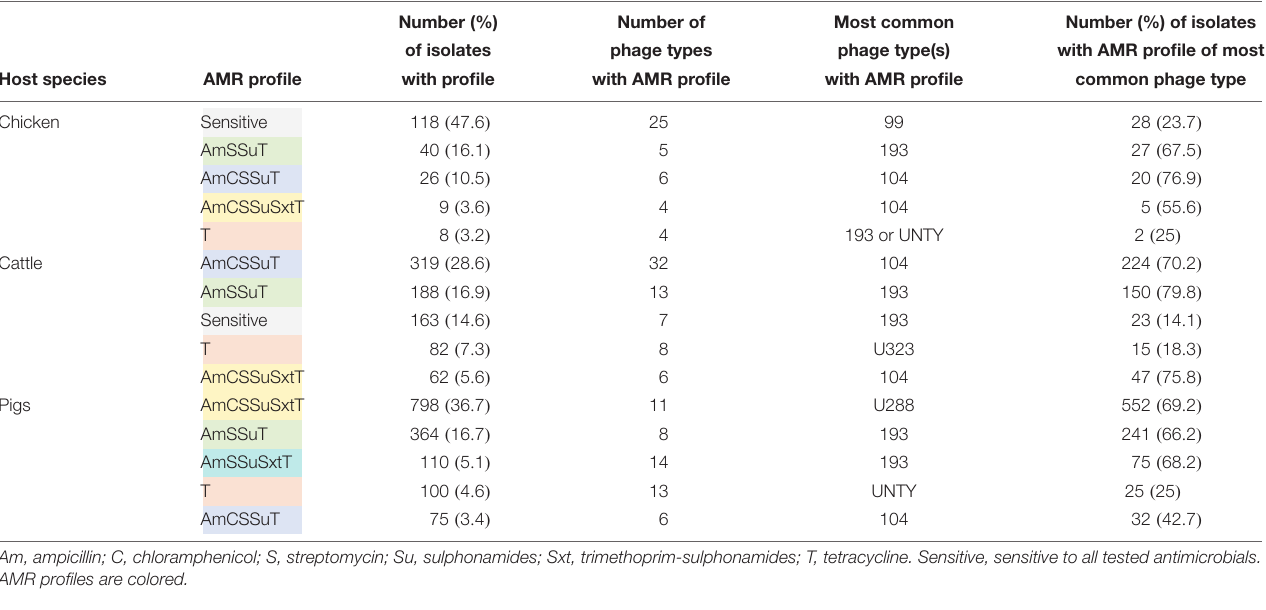
TABLE 4 | Top five most frequent AMR profiles for each host species.